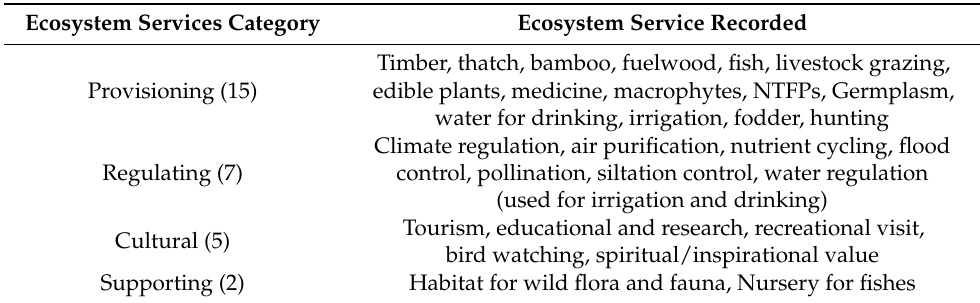
Table 2. List of ecosystem services identified in the study area. Source: Household survey, 2013, Focus group discussions and stakeholders workshop.